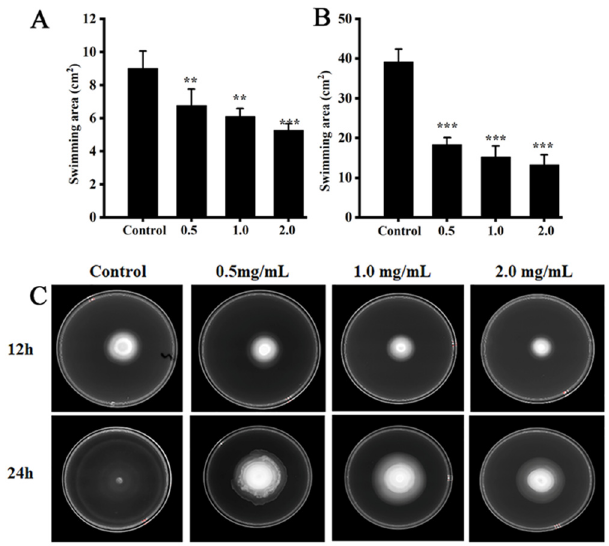
Figure 6. Effects of butyrate on the swimming motility of S. Typhimurium SL1344 at ( A ) 12 h, ( B ) 24 h, and ( C ) representative images of swimming motility. “**” and “***” indicates significance compared to the control. “**” p < 0.01, “***” p < 0.001.